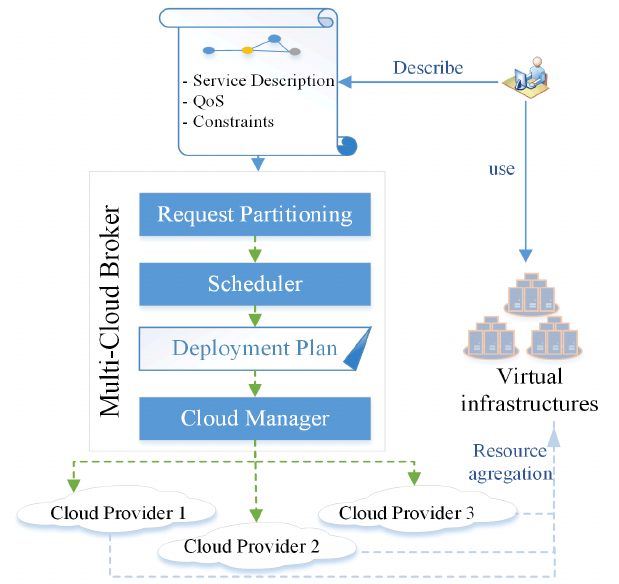
Fig. 2. The MCB Architecture